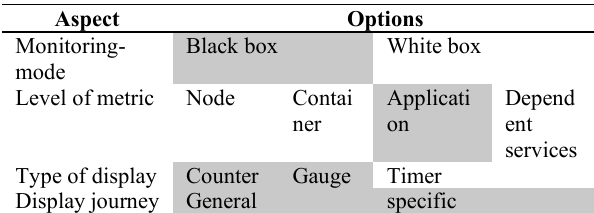
Table 2. Options for Design Aspect